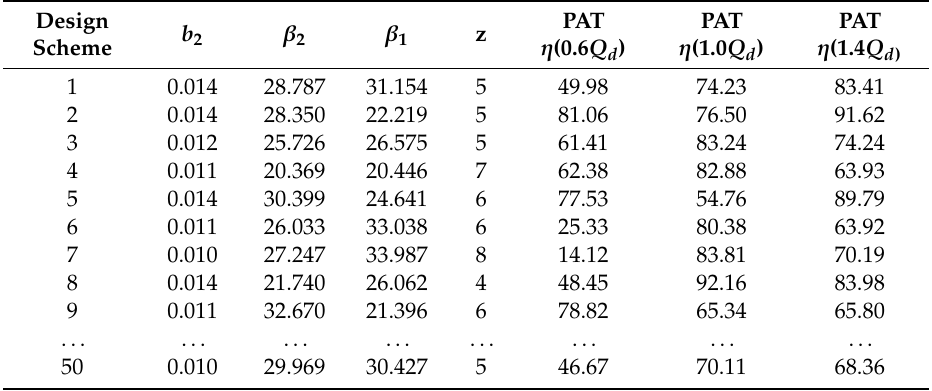
Table 6. Designed schemes and objective